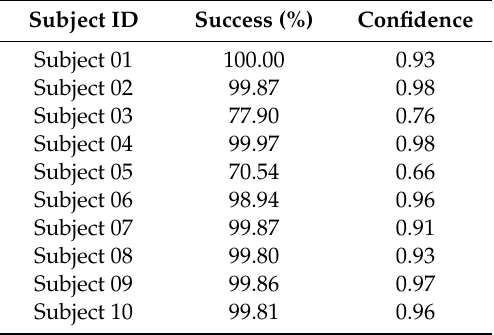
Table 4. Indices of performance of landmark identification and face classification on visible